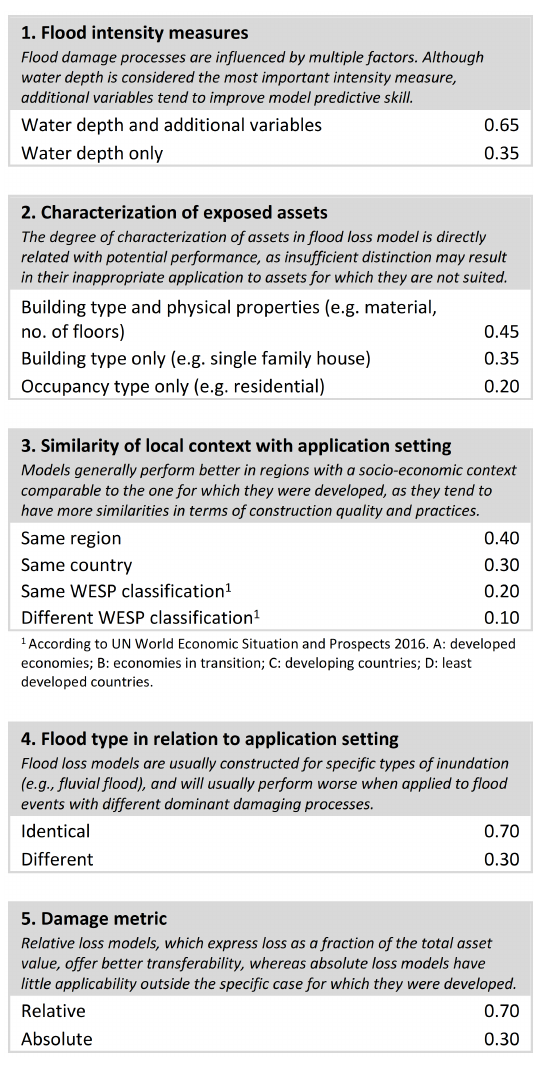
Figure 3. Proposed set of properties (probability tree nodes) that are considered relevant to assess the performance of flood loss models for buildings, and respective categories and subjective